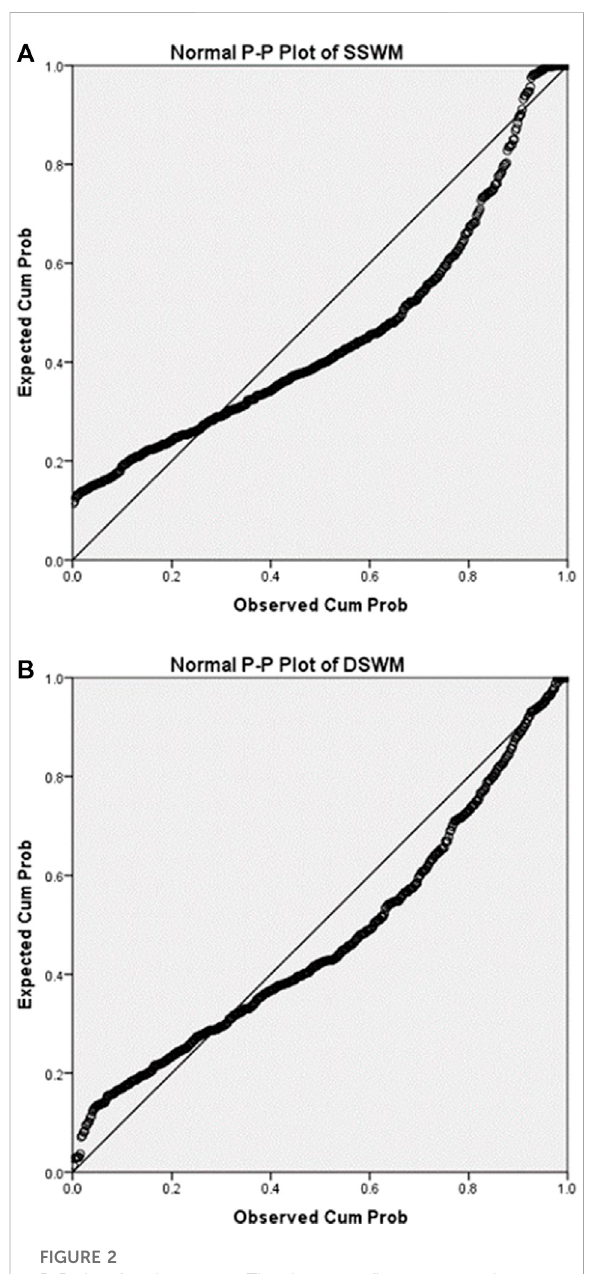
FIGURE 2 P-P plots for phenotypes. The above two fi gures summarise ‘ consistency between the cumulative proportion of data of DSWM and the cumulative proportion of normal distribution ’ (A) , ‘ consistency between the cumulative proportion of data of SSWM and the cumulative proportion of normal distribution ’ (B) . The closer the scatter distribution is to the diagonal, the more the data conforms to the normal